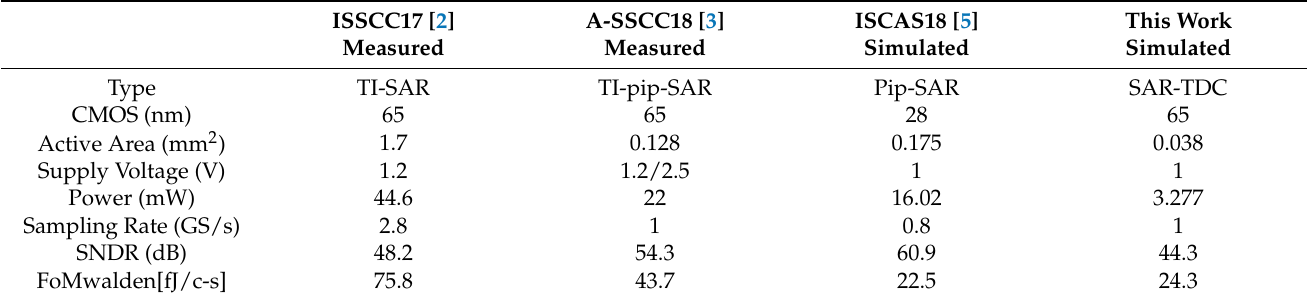
Figure 11. Post-simulated SNDR versus input frequency. Table 1. Performance